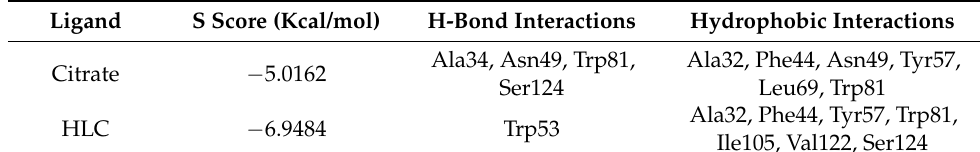
Table 2. Docking results for both citrate and HLC with S. marcescens SmaR.